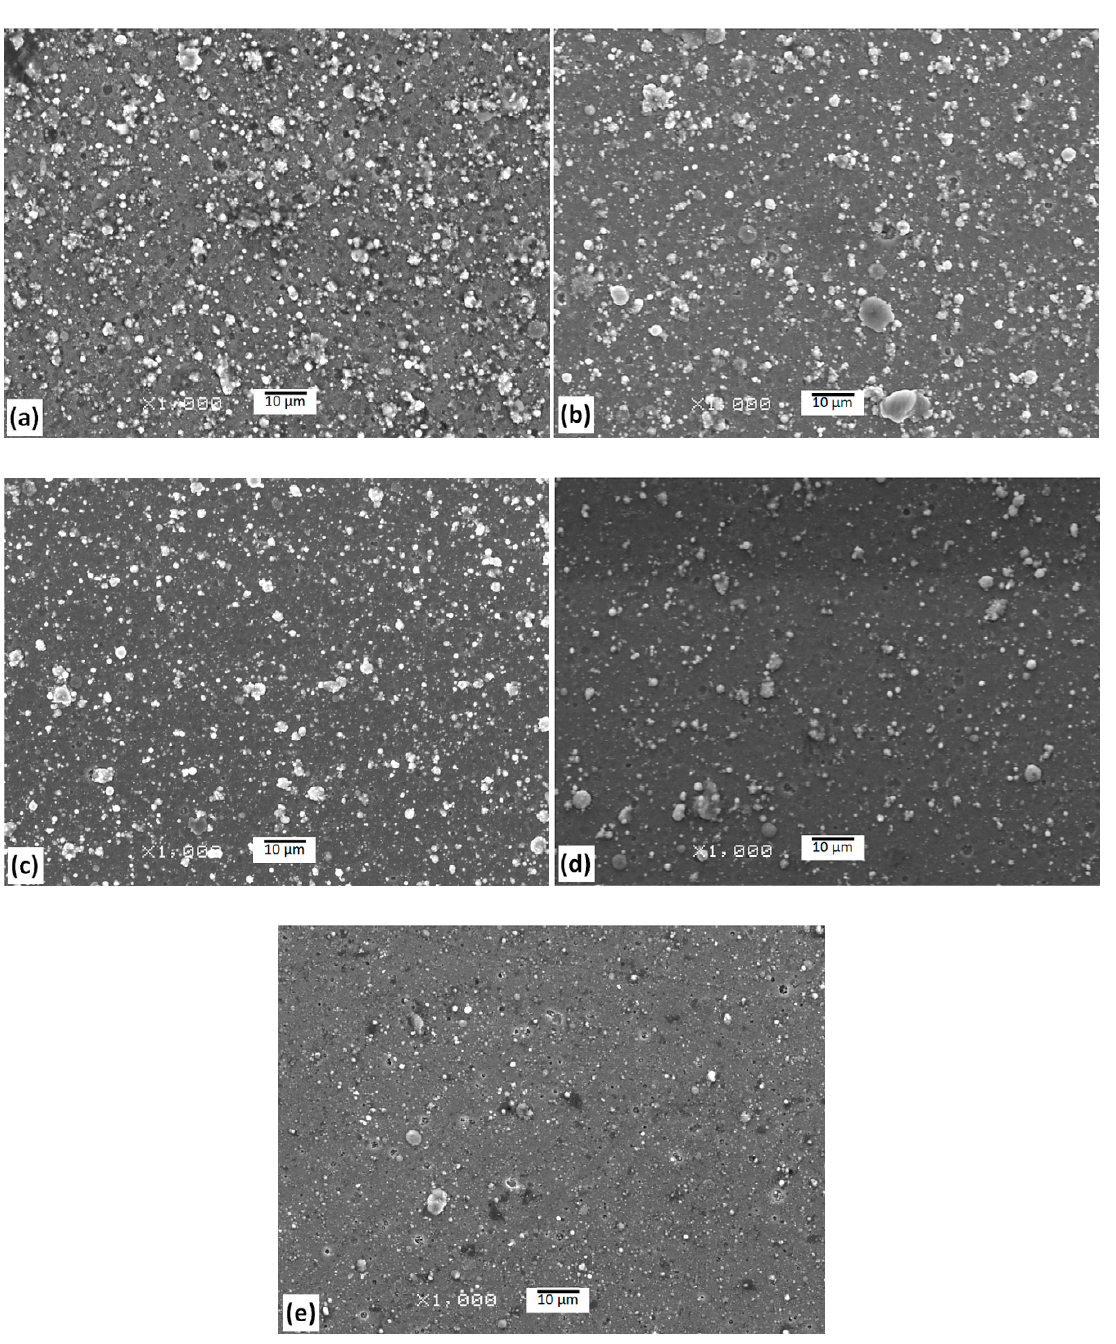
Figure 6. SEM images of AlCrN coatings deposited at 350 °C and different nitrogen pressure. ( a ) 1 Pa; ( b ) 2 Pa; ( c ) 3 Pa; ( d ) 4 Pa; ( e ) 5 Pa.